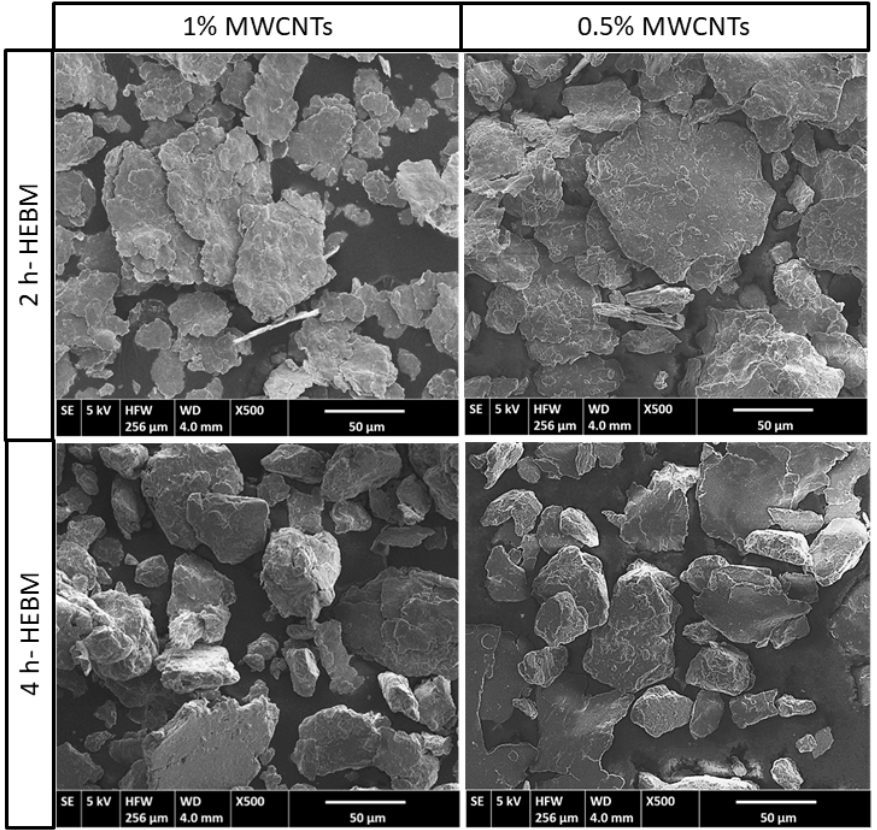
Figure 6. SEM Morphology evolution of composite powders of 7075-1 wt.% MWCNT and 7075-0.5 wt.% MWCNT after 2 h and 4 h.